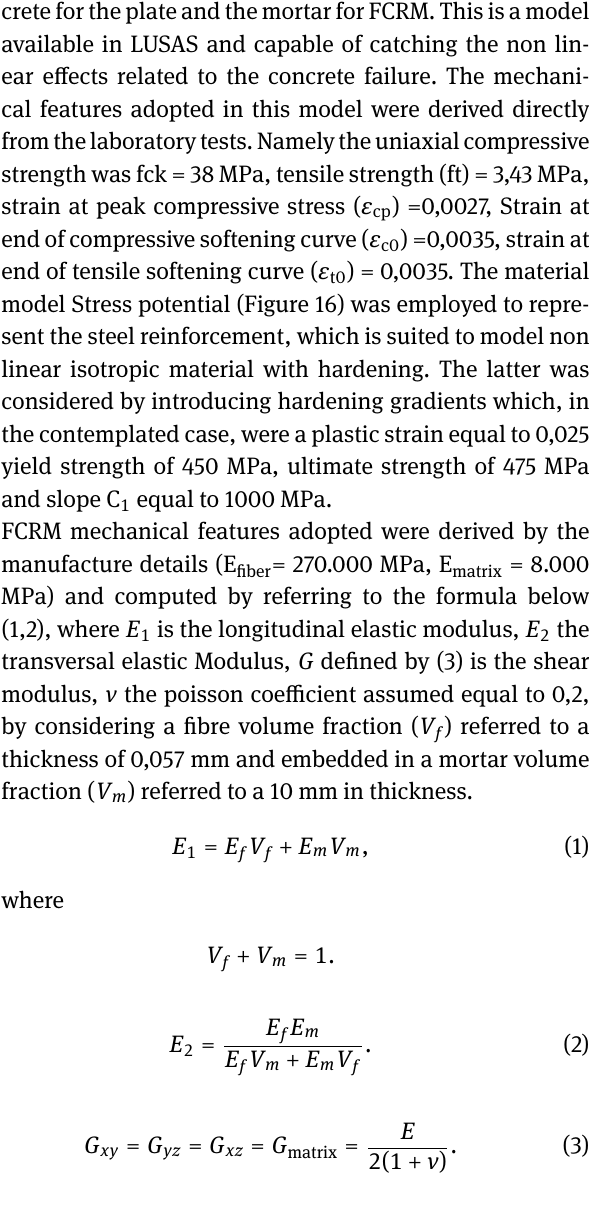
Table 4: Characteristics of the